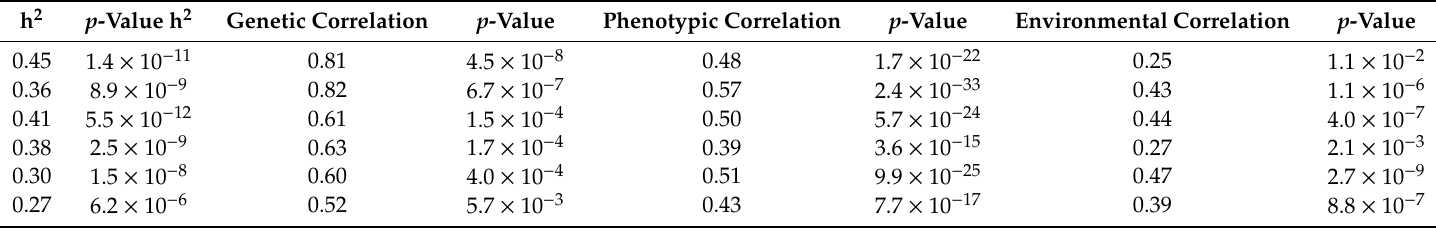
Table 4. Phenotypes with significant genetic correlation with the maximum diameter of the aorta (FDR < 0.05).